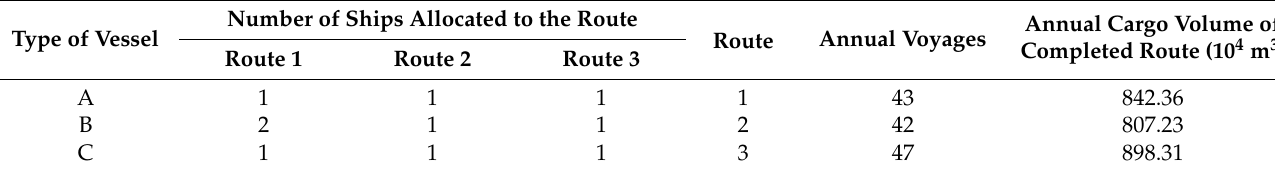
Table 7. Traditional model ship allocation scheme and voyage cargo. Number of Ships Allocated to the Route